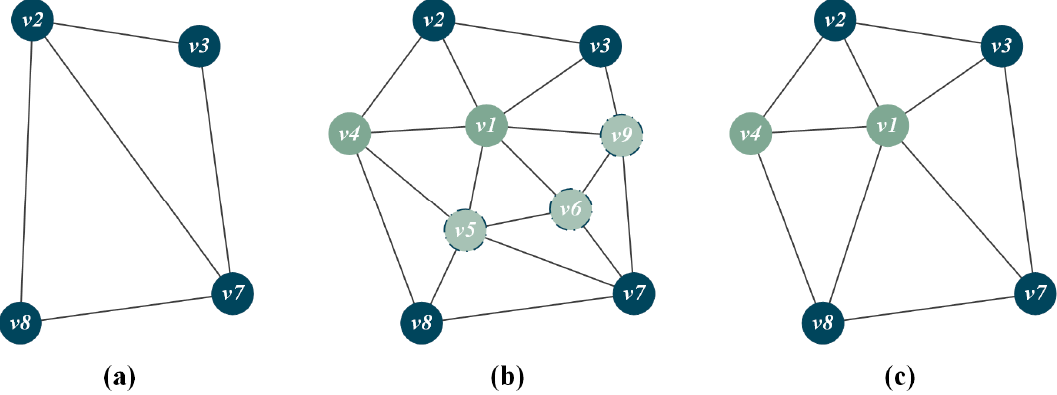
Figure 3. Overcoming neighborhood dependence: ( a ) Current grid; ( b ) neighborhood dependency; ( c ) solutions to overcome neighborhood